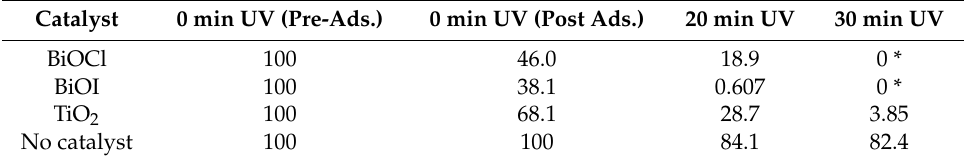
Table 1. Percent of EE2 remaining in solution after treatment with different catalysts and 350 nm light as determined via luminescence spectroscopy. Initial concentration of EE2 was 10.000 mg/L. Experiments were conducted three times and the results were averaged to generate the table below. Reused with permission from reference [12]. Copyright Elsevier